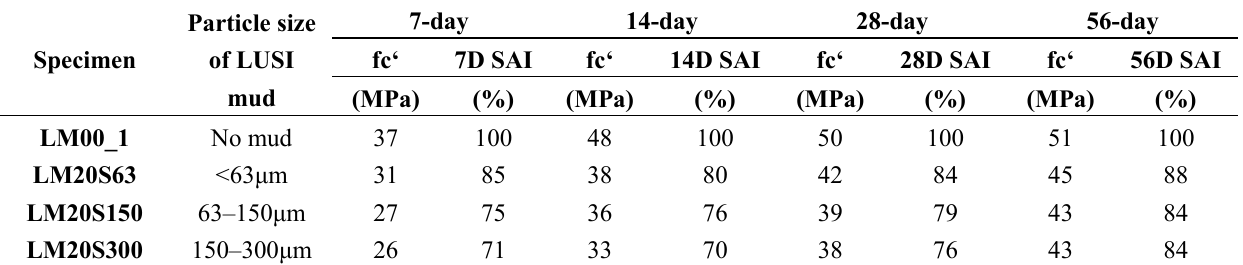
Table 2. Compressive strength and Strength Activity Index (SAI) as a function of particle